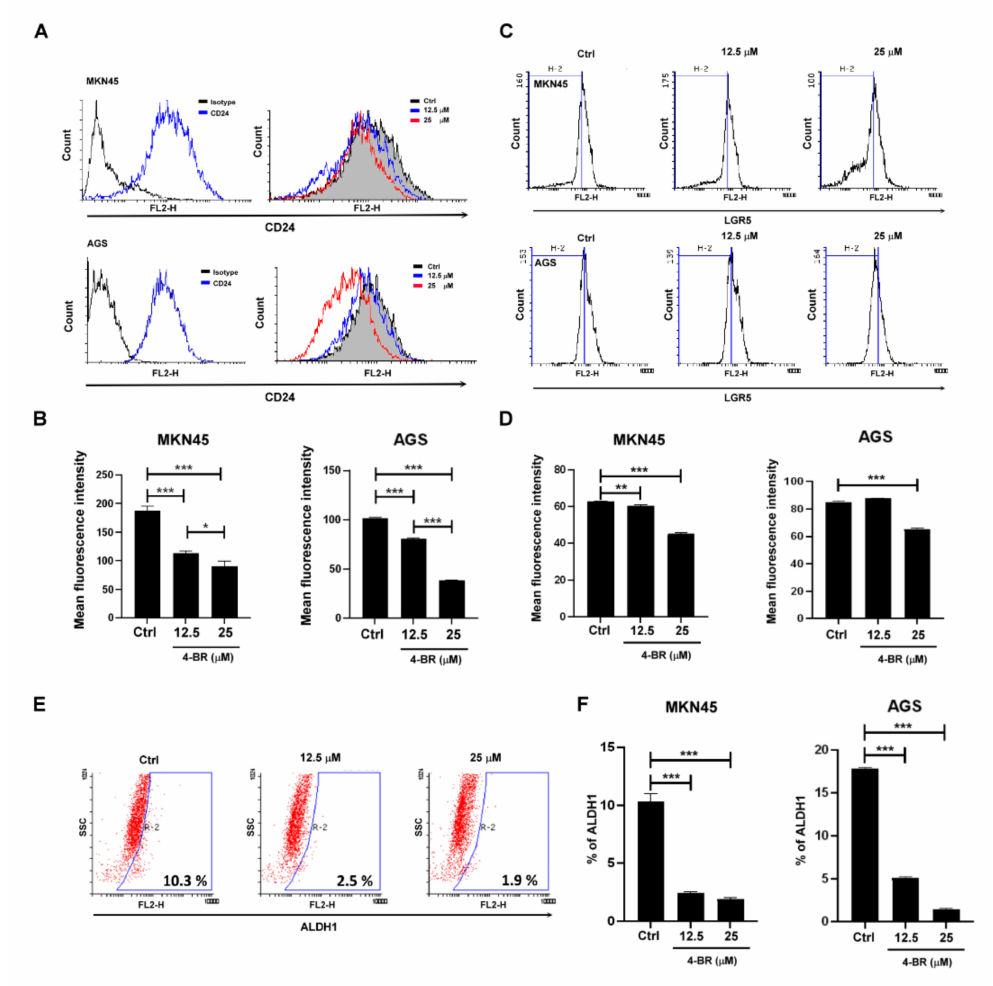
Figure 2. Gastric cancer stemness-related markers were inhibited by 4-BR. ( A ) CD24 expression was analyzed through flow cytometry after 4-BR (12.5 or 25 µ M) treatment for 48 h in MKN45 and AGS cells. ( B ) Quantification of CD24 expression. ( C ) LGR5 expression was analyzed through flow cytometry after 4-BR (12.5 or 25 µ M) treatment for 48 h in MKN45 and AGS cells. ( D ) Quantification of LGR5 expression. ( E ) ALDH1 + cells were analyzed through flow cytometry after 4-BR (12.5 or 25 µ M) treatment in MKN45 and AGS cells. ( F ) Quantification of ALDH1 + cells. Data are presented as means ± standard error; n ≥ 3 independent experiments. Student’s t test: * p < 0.05, ** p < 0.01, *** p <